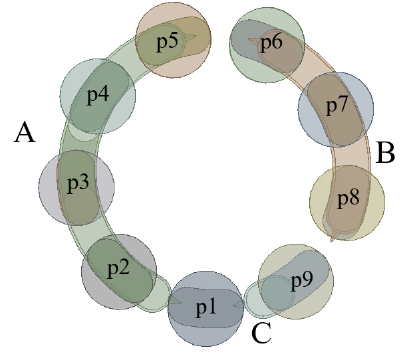
Figure 10. Piston position distribution.